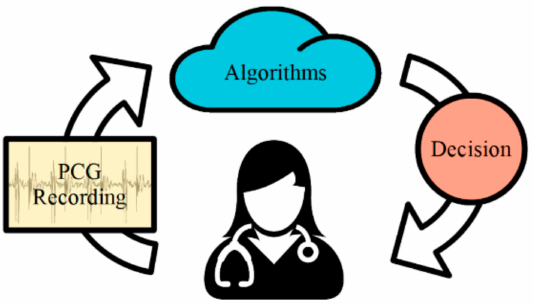
Figure 1. Cloud-based service scheme using phonocardiogram (PCG).